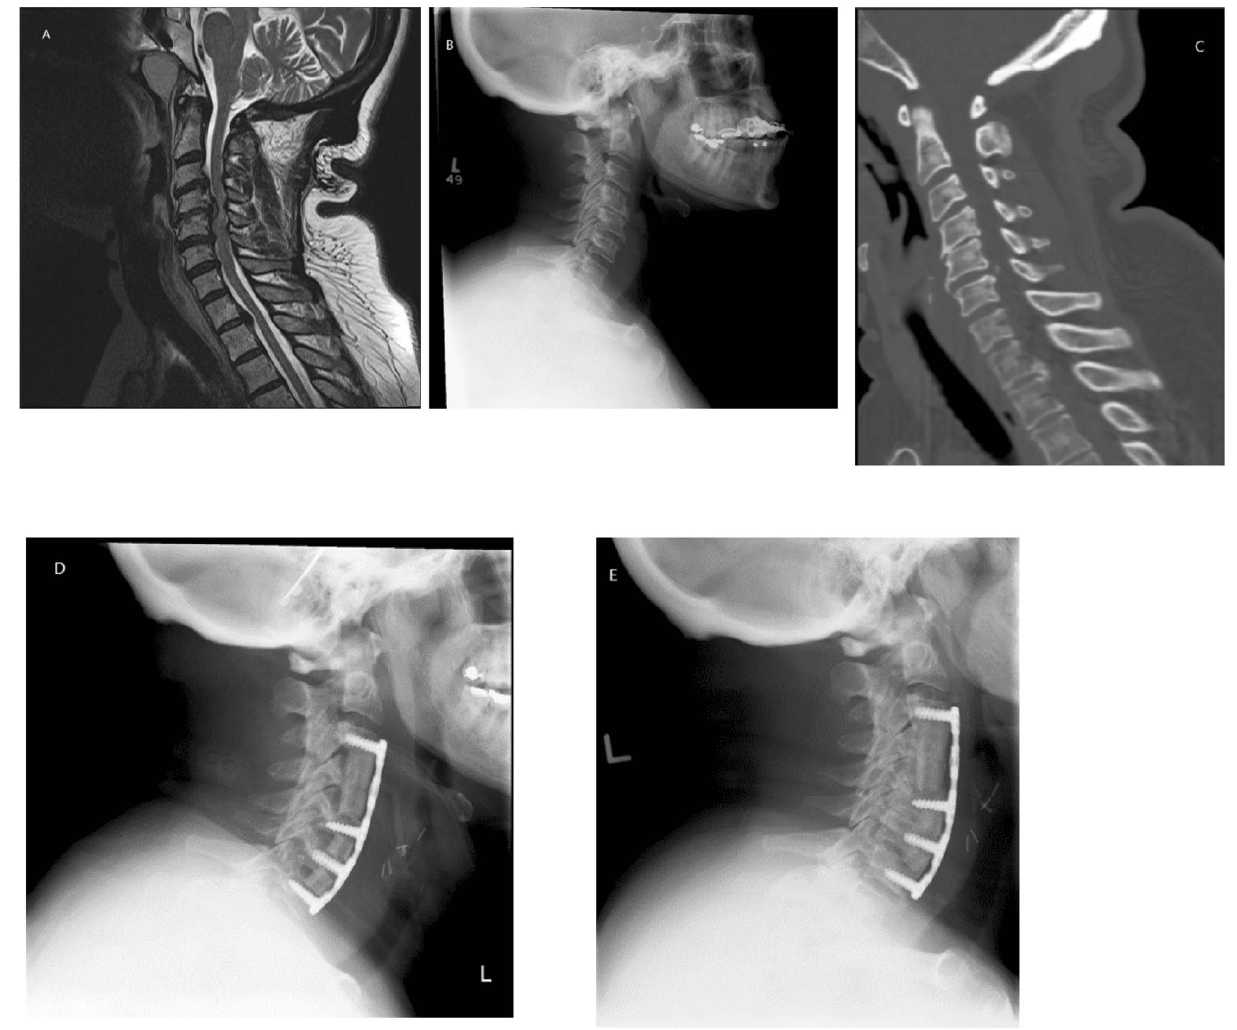
Figure 2. A 65-year-old female who presented with severe progressive cervical spondylotic myelopathy. MRI scan of the cervical spine showed multi-level cervical spondylosis with quite severe anterior cord compression, particularly at the C4/C5 level where there was a large partially sequestered disk ( A ). There was also significant spondylosis at C3/C4 and at C5/C6, and there was fairly significant degeneration of the foraminal narrowing at C6/C7 ( B , C ). The patient underwent a multilevel ACDF with C4 corpectomy ( D ). At the last follow-up 2 years postoperatively, X-rays of the cervical spine showed good alignment and solid fusion across each disc segment ( E ).